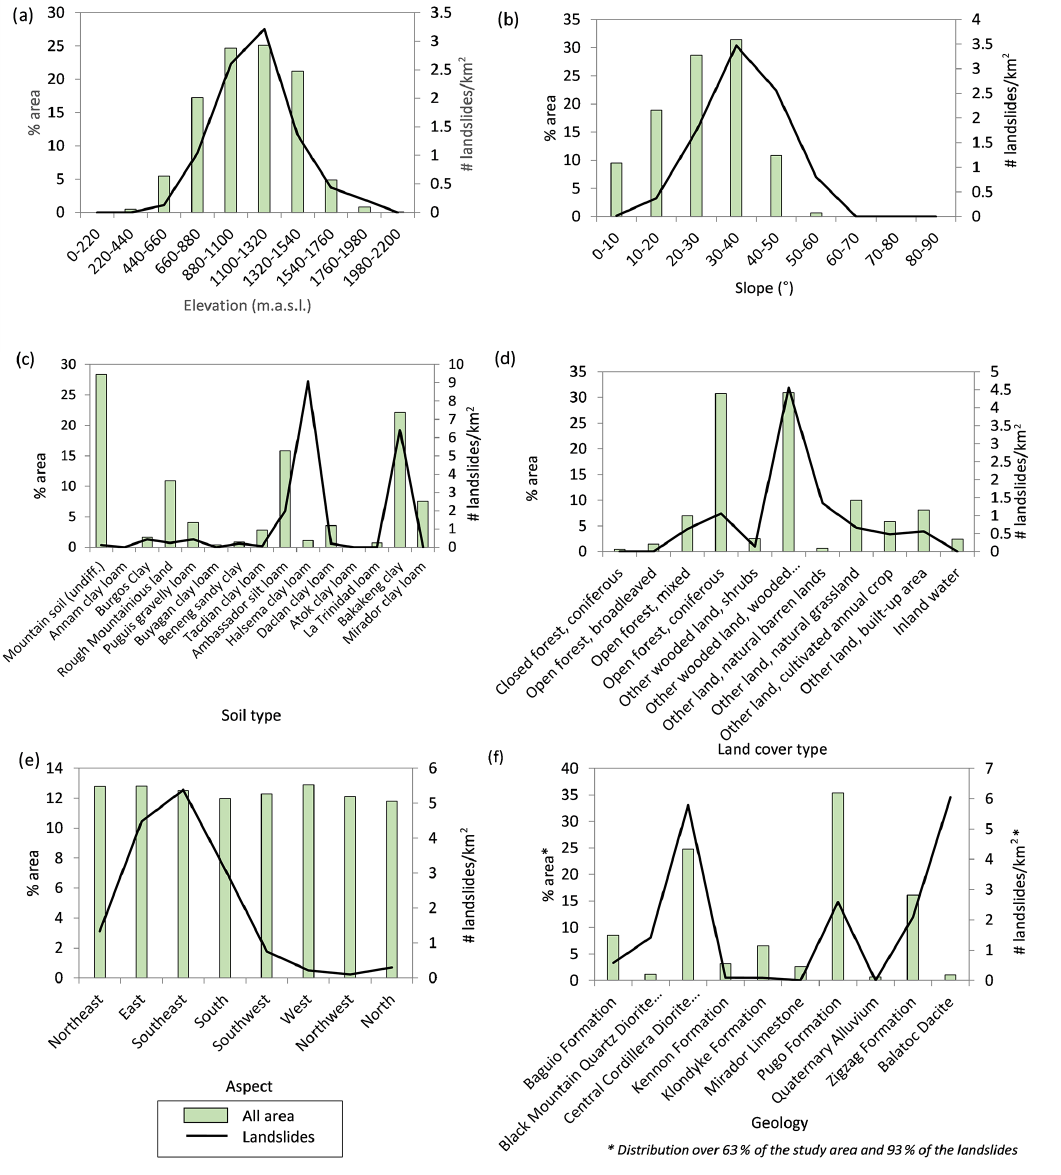
Figure 4. Histograms of different geomorphological parameters over the study area and frequency of landslides for every parameter class. The geomorphological parameters are (a) elevation, (b) slope, (c) soil type, (d) land cover type, (e) aspect, and (f) geology. Note that geology is only over 63% of the study area and 93% of the landslides as the geology map was only available for part of the